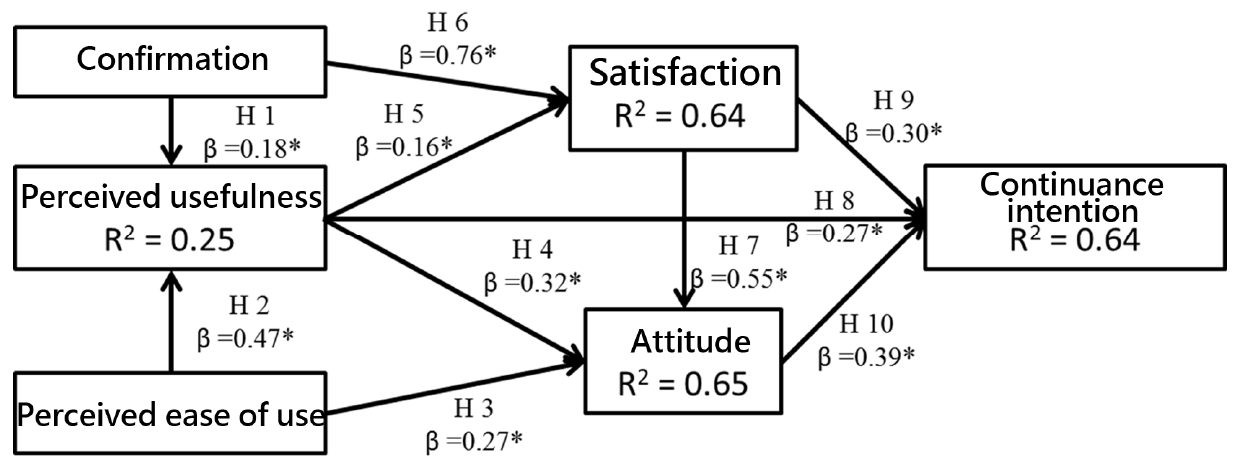
Figure 1. Path analysis of variables in research framework (preload-based comparison); Note: * p < 0.001.